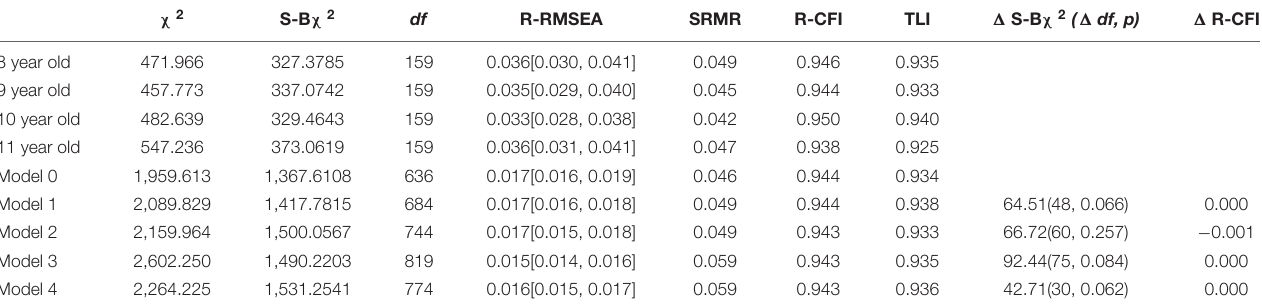
TABLE 4 | Goodness-of-fit indexes for CSAS-P depending on child’s